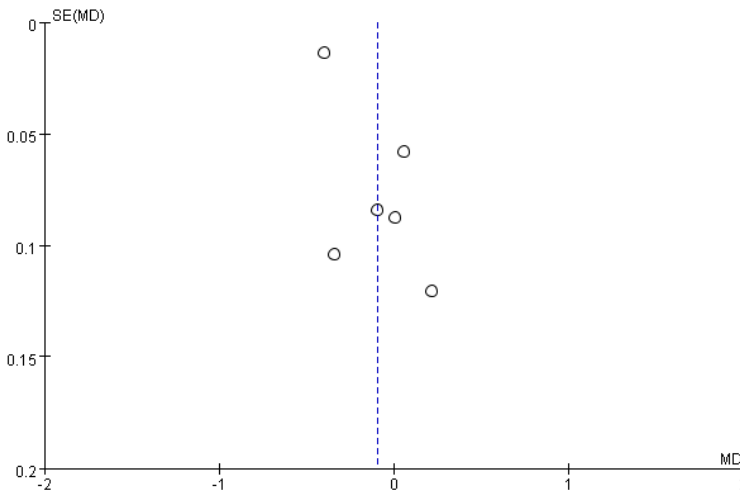
Figure 7. Funnel plot for plaque index outcome.